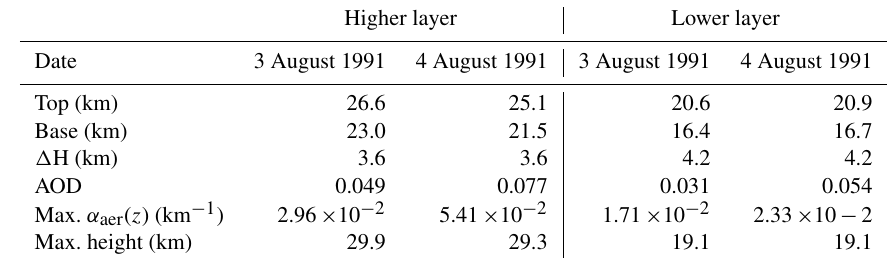
Table 2. Geometrical and optical parameters of the higher and lower layers present in the 3 and 4 August α aer ( z ) profiles. Higher layer